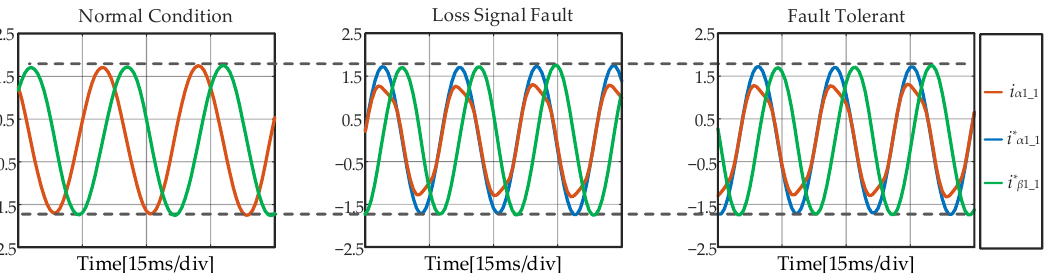
Figure 14. i α 1_1 , i * α 1_1 and i * β 1_1 in different conditions.